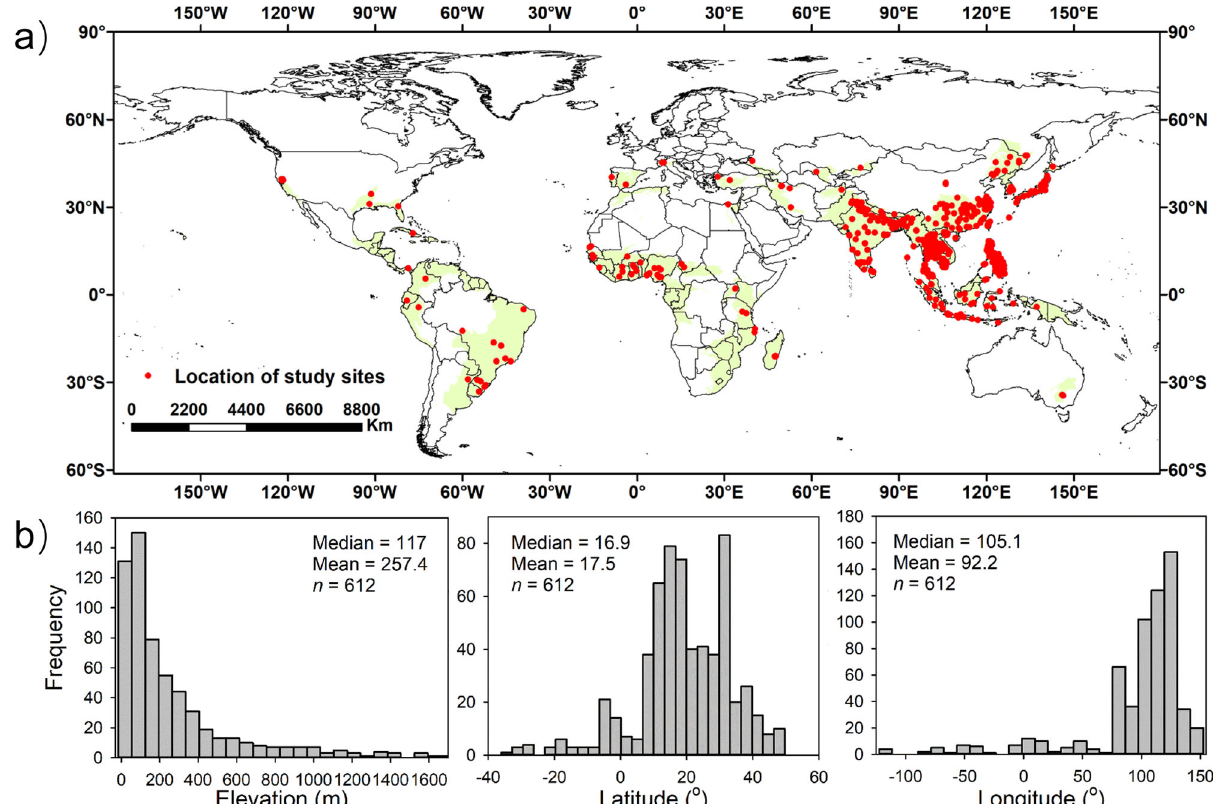
Fig. 1 Overview of spatial ranges of the study. a Distribution of the sites from the peer-reviewed literature reporting paddy SOC stocks (612 sites). Areas with rice paddies are colored green. b Frequencies in absolute cases of the global distribution of elevation, latitude, and longitude for paddies.